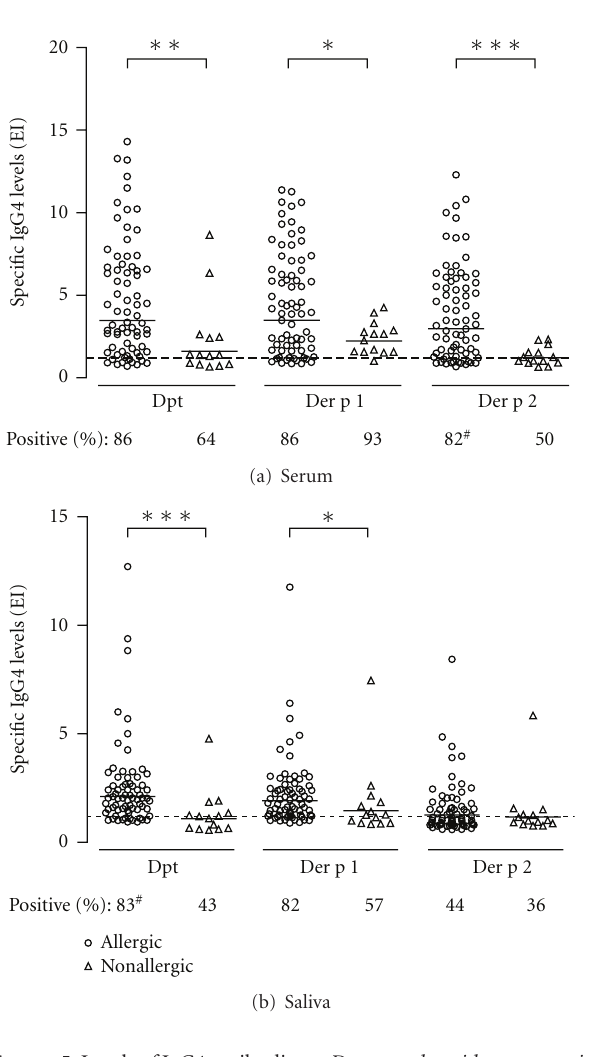
Figure 5: Levels of IgG4 antibodies to Dermatophagoides pteronyssi- nus (Dpt) crude extract and its major allergens (Der p1 and Der p2) in serum (a) and saliva (b) samples from allergic ( n = 72) and nonallergic ( n = 14) infants. Data are expressed in ELISA index (EI) and the geometric mean for each allergen is indicated by horizontal bars. The dashed line indicates the cut o ff of the reaction (EI > 1 . 2) and percentages of positive IgG4 samples for each allergen are also indicated. ∗ P < 0 . 05; ∗∗ P < 0 . 001; ∗∗∗ P < 0 . 0001 as determined by the Mann-Whitney U test; # Statistical significance determined by the Fisher exact test ( P < 0 .